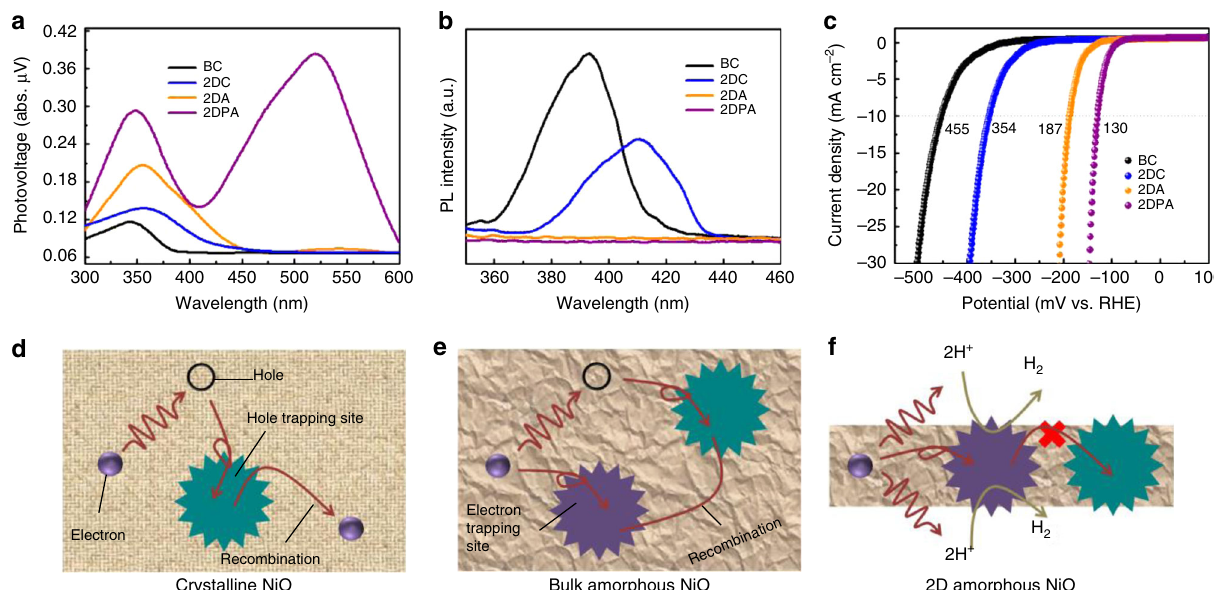
Fig. 4 Exploration of the photocatalytic mechanism. a SPV spectra, b PL spectra and c electrocatalytic polarization curves of the BC (black), 2DC (blue), 2DA (orange) and 2DPA (purple). d – f Schematic illustration of the photocatalytic H 2 evolution mechanism over crystalline NiO ( d ), bulk amorphous NiO ( e ) and 2D amorphous NiO ( f